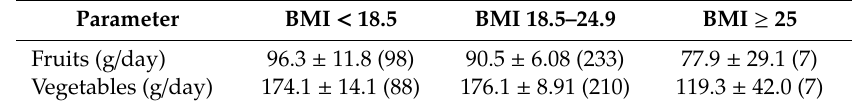
Table 5. Daily consumption of fruits and vegetables by body mass index (BMI) category.